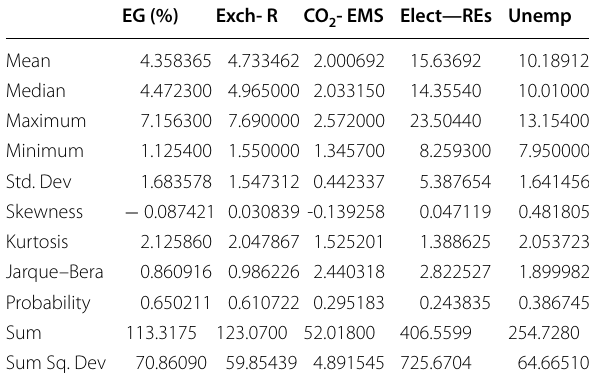
Table 1 Summary of the descriptive statistics